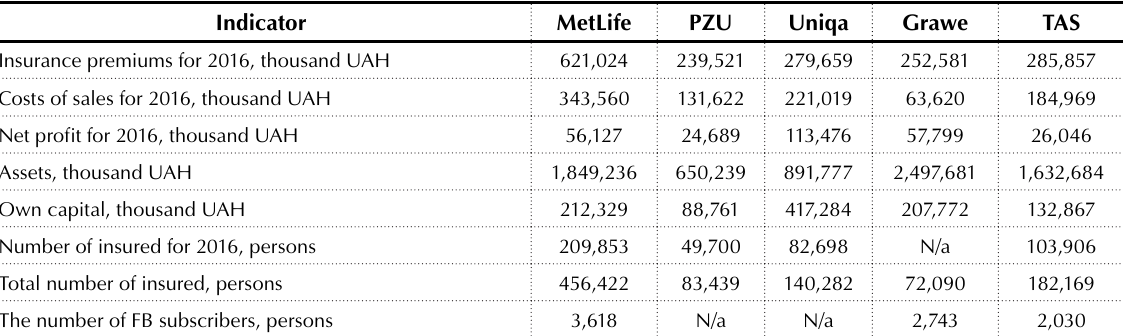
Source: Sites of the